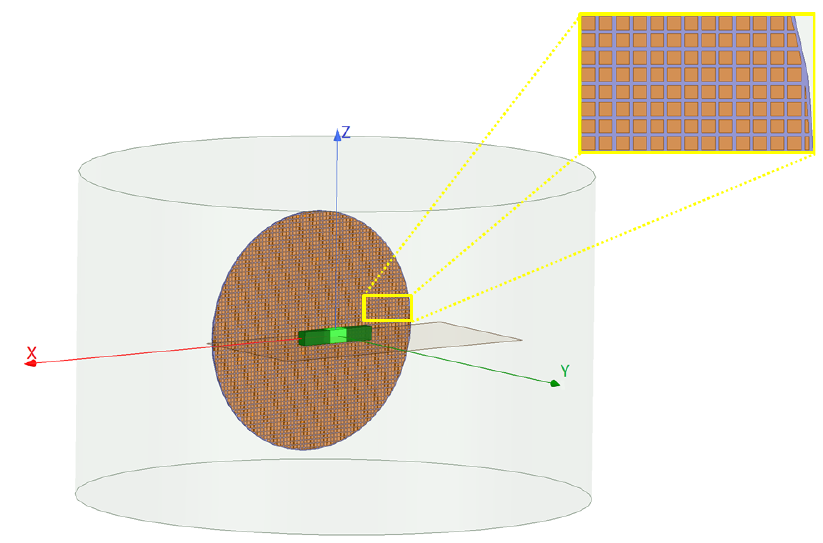
Figure 11. The simulated Bessel beam launcher setup. The Bessel beam launcher (orange circular structure), introduced in [48], is parallel to the xz plane. A more detailed view of the capacitive sheet is shown in the inset. The brown plane ( xy plane) contains the cross section of three dielectric boxes, all of which have the same relative permittivity of two. This figure represents our Case II study where the light green dielectric box, with the size of λ /2 × λ /4 × λ /3, represents the OI, and the two dark green dielectric boxes, with the size of 3 λ /4 × λ /4 × λ /3, serve as the undesired